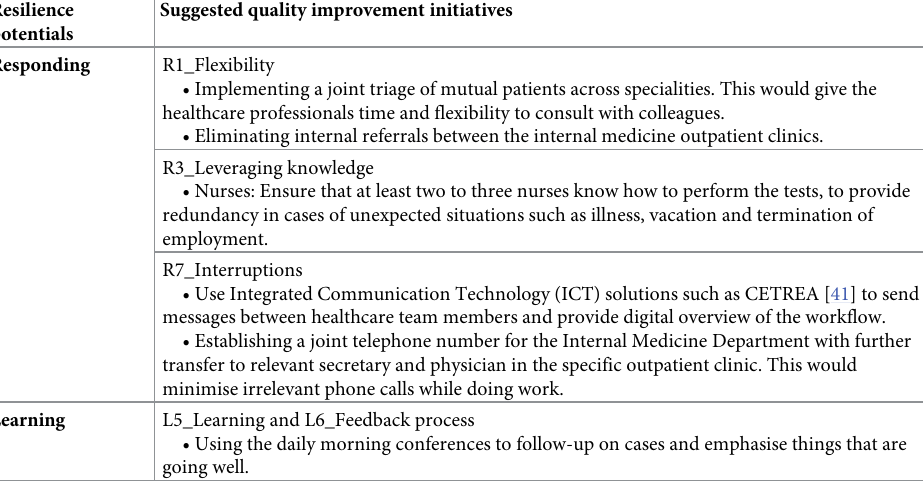
Table 3. Overview of suggested quality improvement